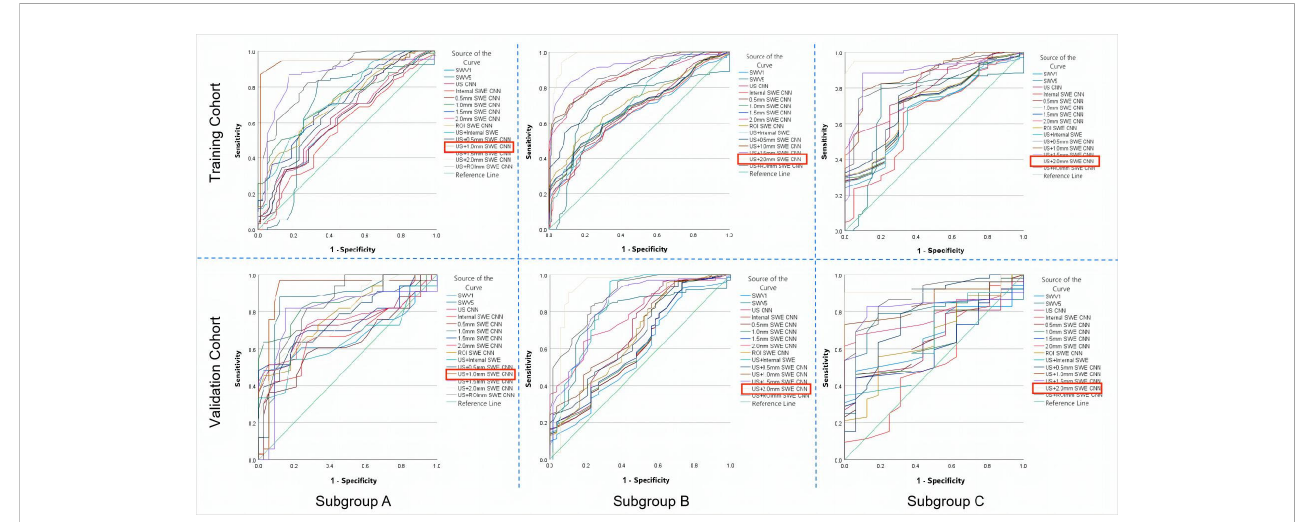
FIGURE 8 The ROC curves of the prediction CNN models and the quantitative SWE parameters (SWV1 and SWV5) in both the training and the validation cohorts for the three subgroups. (A) Based on the ROC curves of the subgroup with MD ≤ 15 mm, the US + 1.0 mm SWE CNN showed the highest AUCs in the training (0.94) and in the validation (0.91) cohorts. (B) From the ROC curves of the subgroup with 15 mm< MD ≤ 25 mm, the US + 2.0 mm SWE CNN showed the highest AUCs in the training (0.96) and in the validation (0.93) cohorts. (C) From the ROC curves of the subgroup with MD >25 mm, the US + 2.0 mm SWE CNN showed the highest AUC in both the training (0.95) and the validation (0.91) cohorts. ROC, receiver operating characteristic; AUC, area under the ROC curve; MD, maximum diameter of the lesion. The best values are shown in red box